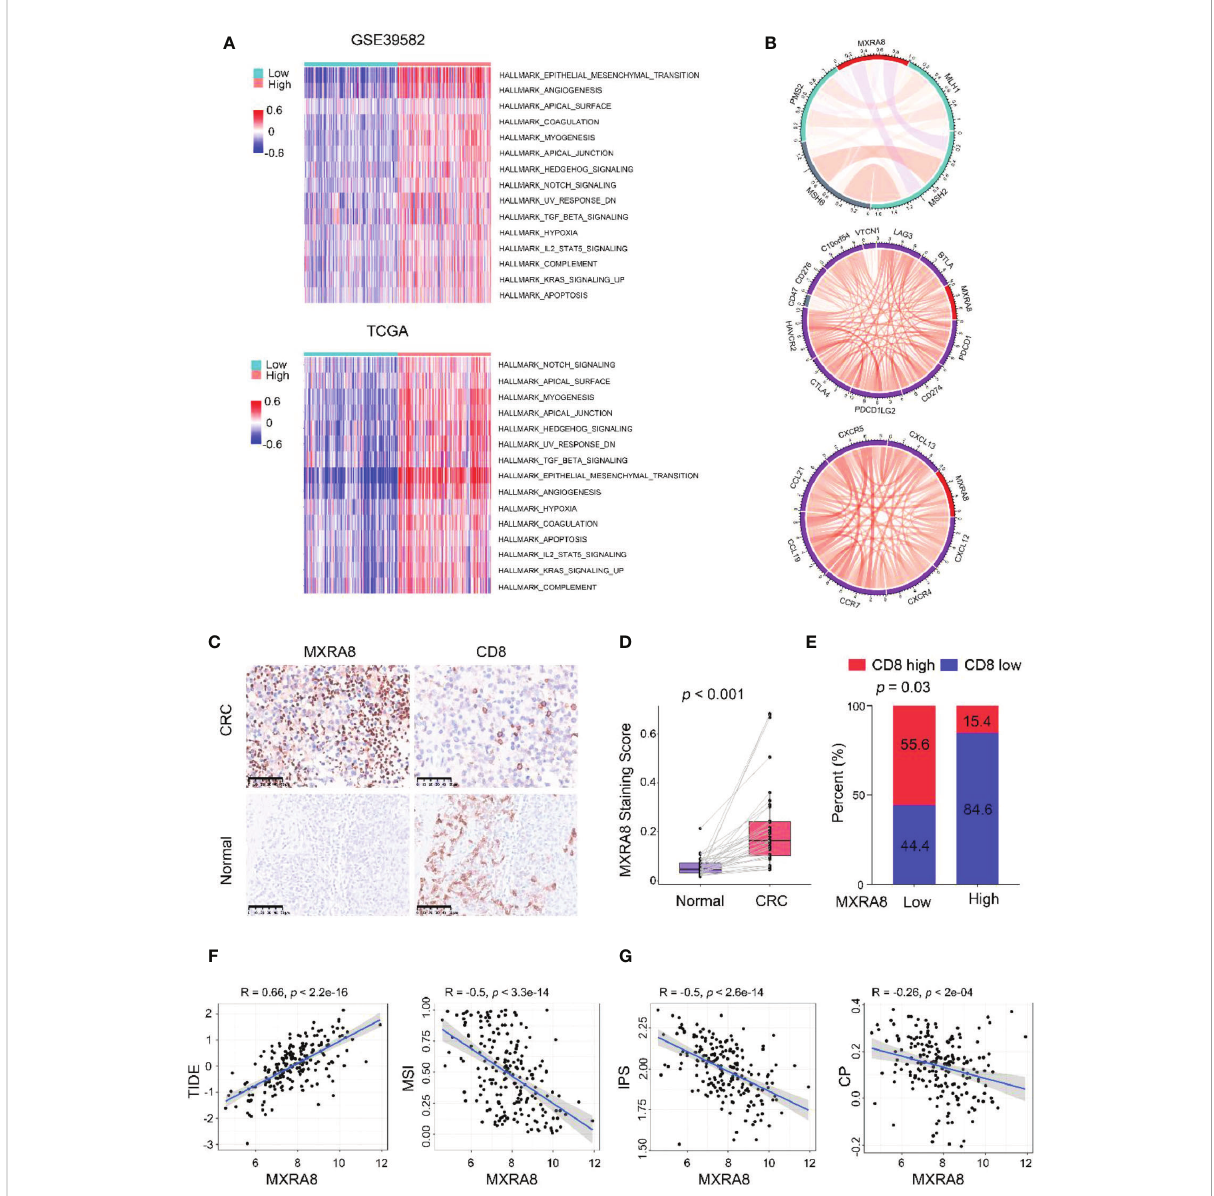
FIGURE 4 MXRA8 promotes CRC migration and immunosuppression. (A) GSVA analysis of hallmark and KEGG pathway gene sets in MXRA8 high and low expression samples from GSE39582 and TCGA datasets. (B) In TCGA, MXRA8 expression is negatively associated with microsatellite instability but positively associated with immune checkpoint molecule expression, chemokines, and chemokine receptors expression. (C) IHC images of MXRA8 protein expression in normal and tumor tissue. Scale bars, 50 m m. (D) Statistical analysis of MXRA8 expression in CRC and adjacent normal tissues. (E) Statistical analysis of the correlation between MXRA8 and CD8 expression in CRC tissues. (F, G) MXRA8 expression is positively linked to tumor immune dysfunction and exclusion (TIDE) and negatively associated with microsatellite instability (MSI), immunophenoscore (IPS), and checkpoint